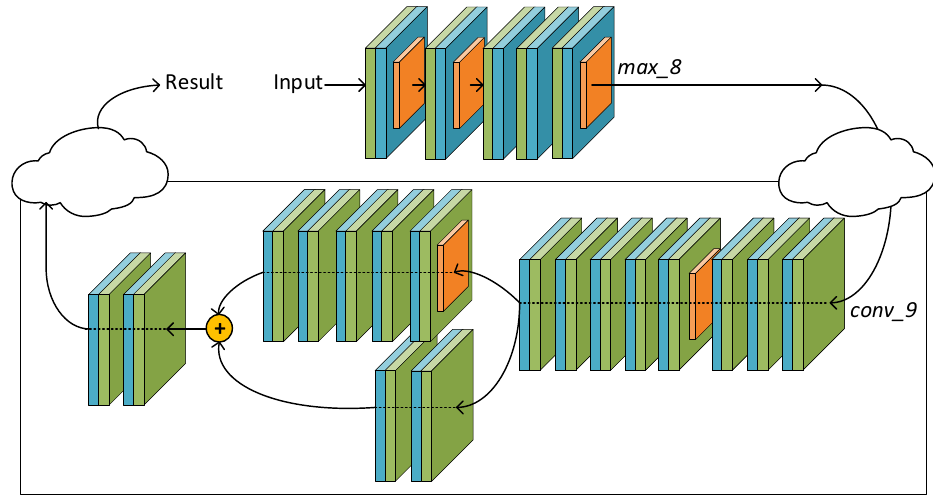
Figure 5. YOLOv2 split into two separate instances with the output of the eighth layer communicated over the